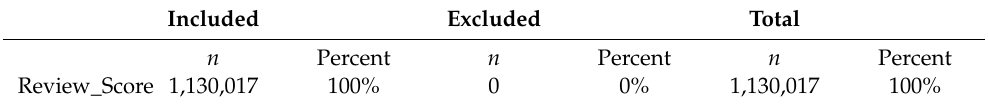
Table 1. Summary of Missing Values.